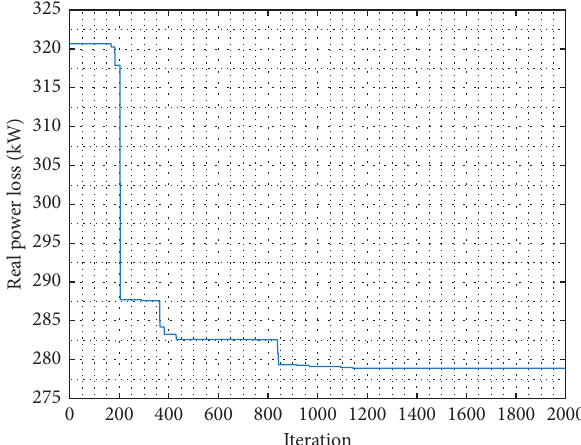
Figure 14: Convergence characteristic of power loss for the 136- bus system.